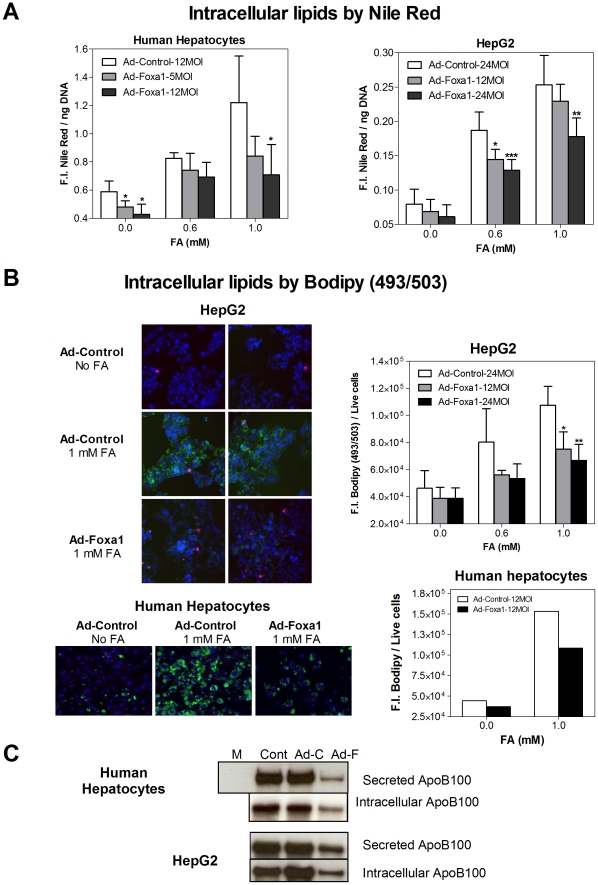
Foxa1 reduces lipid accumulation and ApoB100 secretion in human liver cells.(A) Cultured human hepatocytes and HepG2 cells were transduced with Ad-Foxa1 or Ad-Control for 24 h and then exposed to FA (oleate: palmitate, 2∶1). Twenty-four hours later, accumulated lipids were quantified by Nile Red fluorescence. Data represent the mean±SD of 4–5 independent experiments. * p<0.05; ** p<0.01; *** p<0.001. (B) Left panels: Representative microphotographs of living HepG2 cells and human cultured hepatocytes showing cytoplasmic neutral lipids stained with BODIPY 493/503 (green), nuclei stained with Hoechst 33342 (blue) and death cell nuclei stained with propidium iodide (pink). Right panels: Quantification of the BODIPY 493/503 fluorescent signal with the Olympus ScanR Screening Station in HepG2 cells (mean±SD, n = 4) and in a representative human hepatocyte culture. (C) Secreted (culture medium) and intracellular ApoB100 protein was analyzed by immunoblotting at 48h after infection with adenoviral vectors. (M, fresh culture medium; Cont, non-infected controls; Ad-C, Ad-Control; Ad-F, Ad-Foxa1).